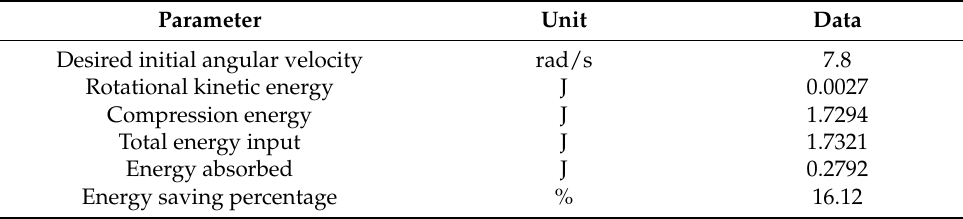
Table 4. Simulation results at 4.3718 m drop height.